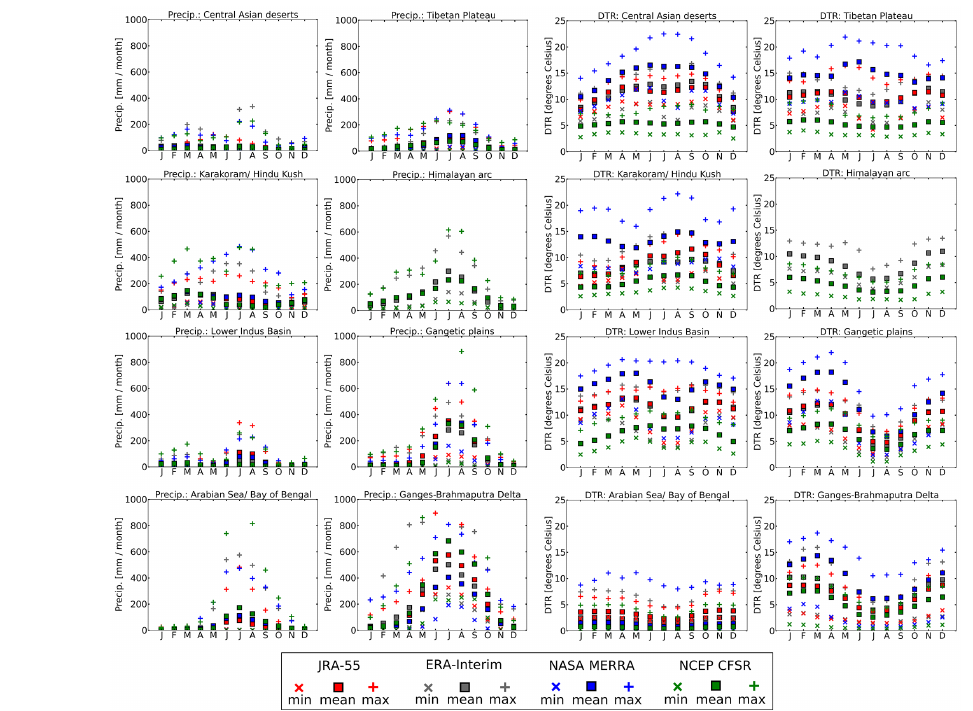
Figure 6. Ensemble spatial statistics for annual cycles of precipitation (left) and DTR (right) by climate zone (eight clusters). DTR is diurnal temperature